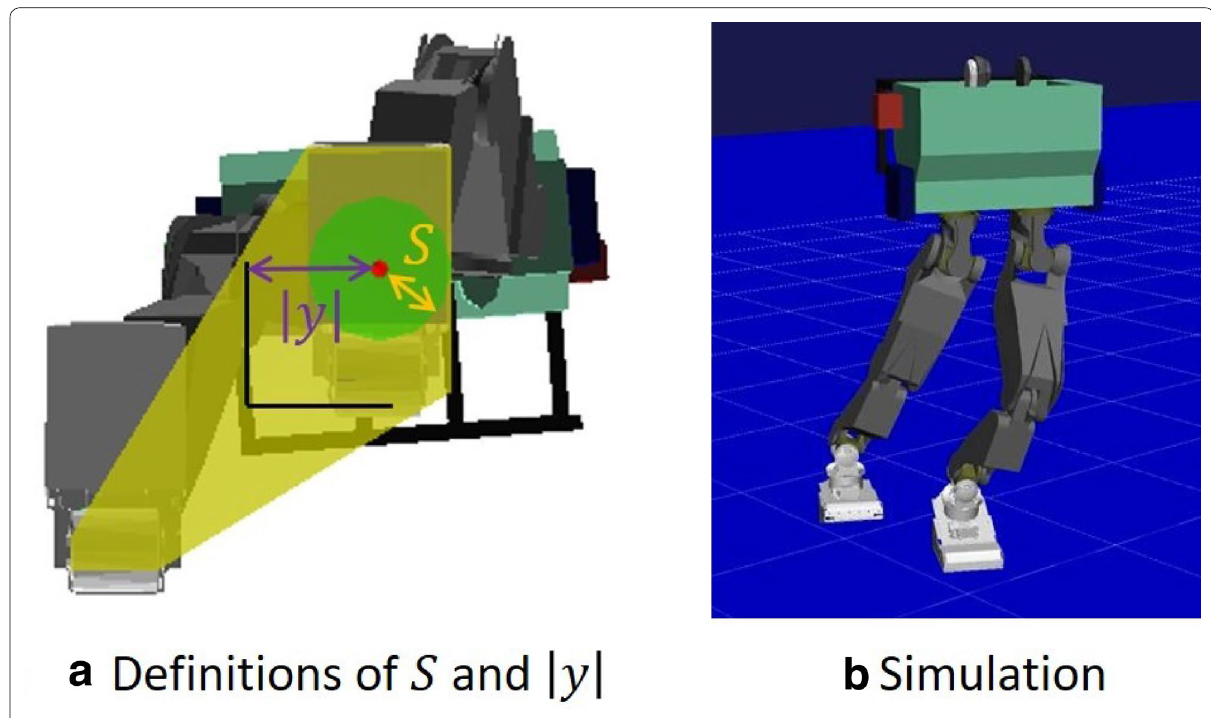
Fig. 6 Single leg stance on Phase3